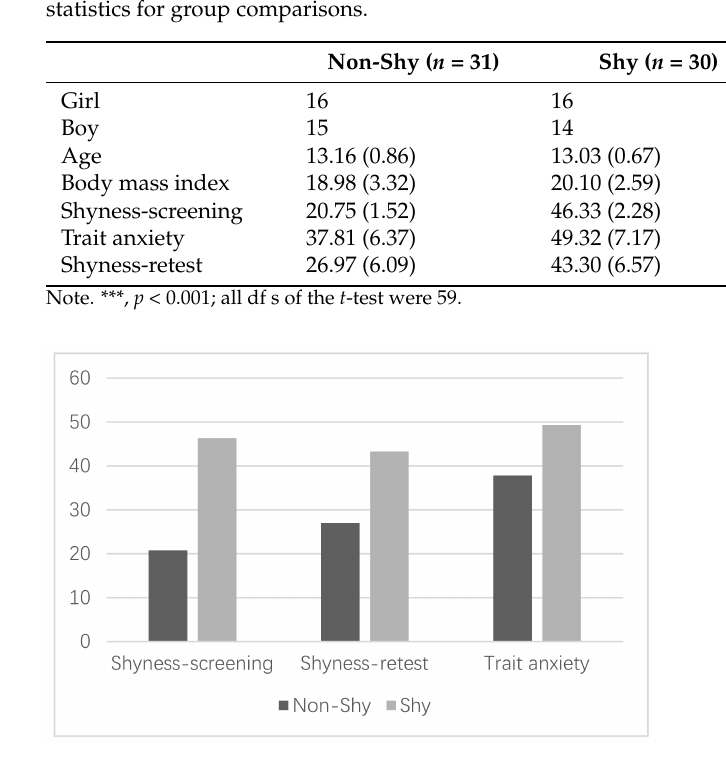
Figure 1. Comparison of the shy and non-shy